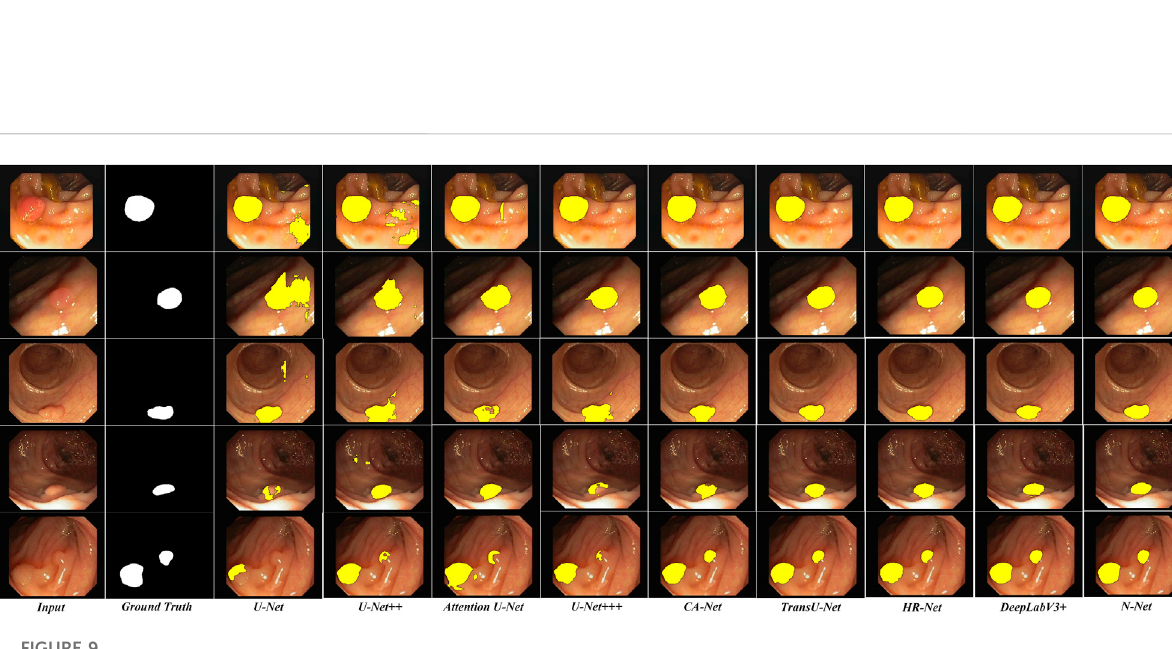
Frontiers in Bioengineering and